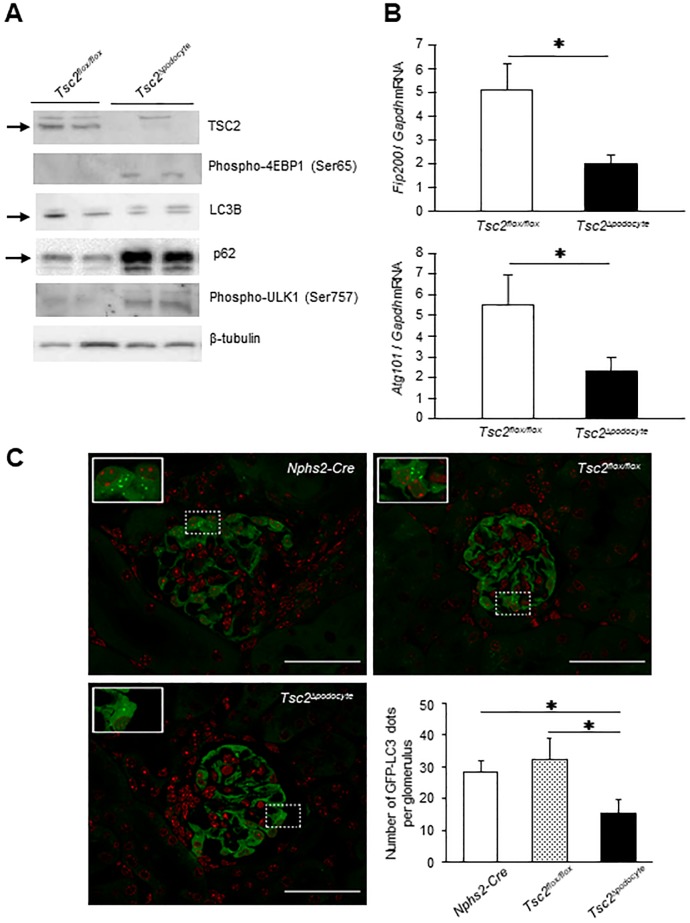
mTORC1 hyperactivation led to a decreased autophagic activity in the podocytes.(A) Primary cultured podocytes were isolated from Tsc2Δpodocyte and wild-type controls, followed by western blot analyses of TSC2, phospho-4EBP1, LC3B type II, p62, phospho-ULK1, and β-tubulin. Arrows indicate specific bands corresponding to each indicated protein. (B) FIP200 and ATG101 mRNA expressions were decreased in the primary cultured podocytes from Tsc2Δpodocyte. (C) Representative fluorescence images of glomeruli of Nphs2-Cre- (top, left), Tsc2flox/flox- (top, right) and Tsc2Δpodocyte-GFP-LC3 transgenic mice (bottom, left) at 4 weeks of age. The white box indicates the location of the magnified figure. Scale bar: 50 μm. (bottom, right) Quantitative analysis of autophagic activity in vivo. Graph bars show the number of GFP-LC3 dots per glomerulus from the indicated mice (n = 3 per group). The number of GFP-LC3 dots per glomerulus was counted in 20 independent visual fields from the indicated mice. Results are expressed as means ± s.d. *P < 0.05 compared with age-matched controls.